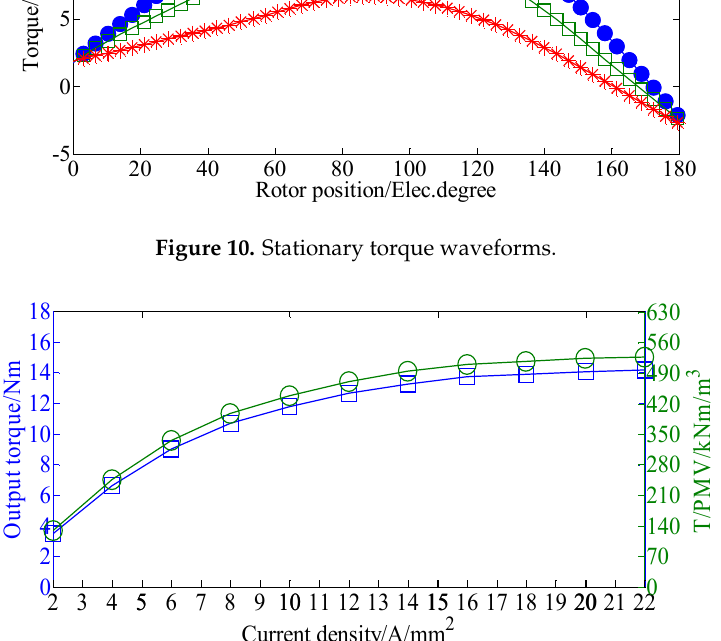
Figure 11. Output torque and T/PMV when applied with different current densities.